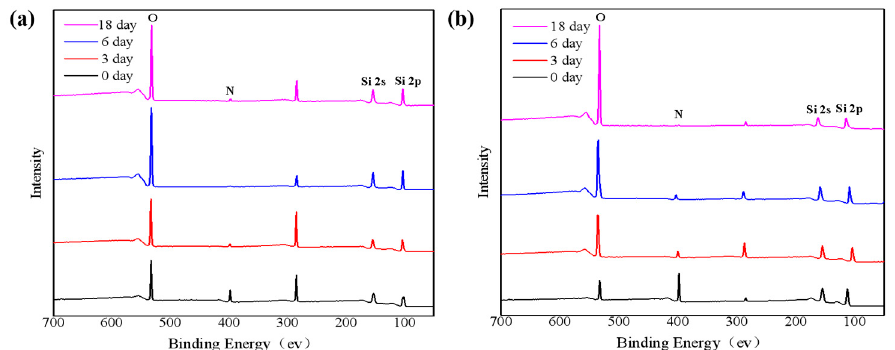
Figure 2. XPS analysis of ( a ) surface and ( b ) 200 nm inside of for SiN x films oxidized at different times under 85 °C/85% RH.